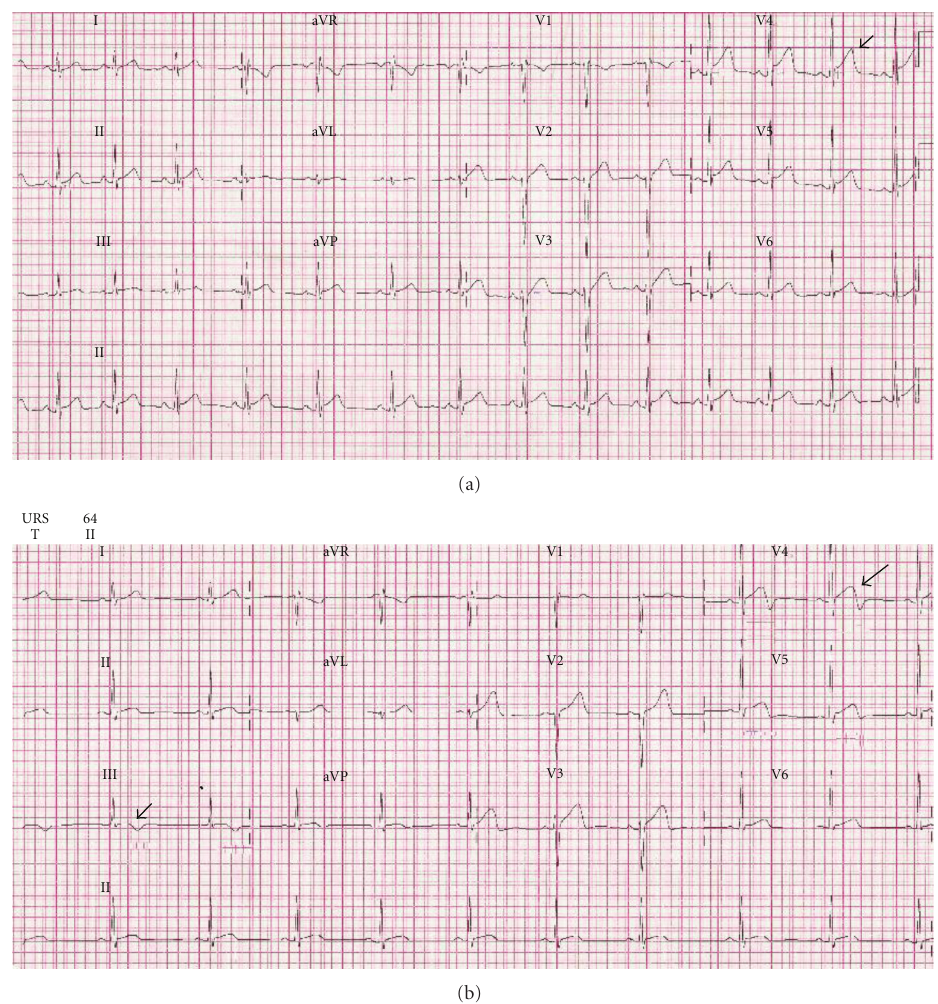
Figure 2: (a) ECG on admission, with changes due to early repolarization. (b) ECG on the third day, with T wave inversion in lead III and biphasic T wave in leads V 4 and V 5